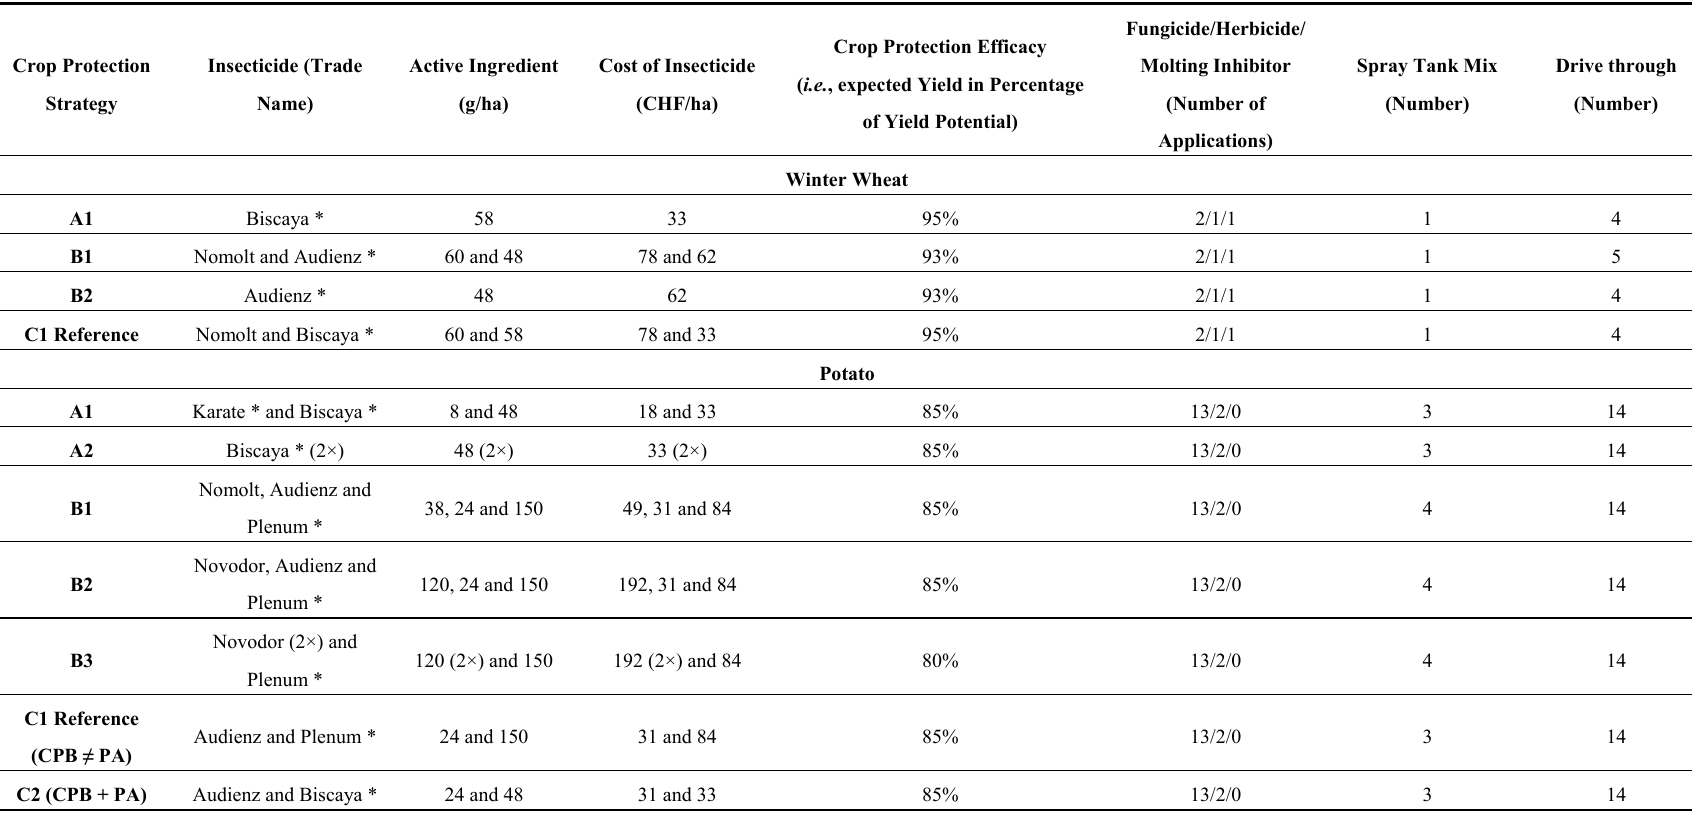
Table 3. Definition of plant protection strategies, based on the assumption that the tolerance thresholds are exceeded for the cereal leaf beetle ( Oulema melanopus ), Colorado potato beetle ( Leptinotarsa decemlineata ), and potato